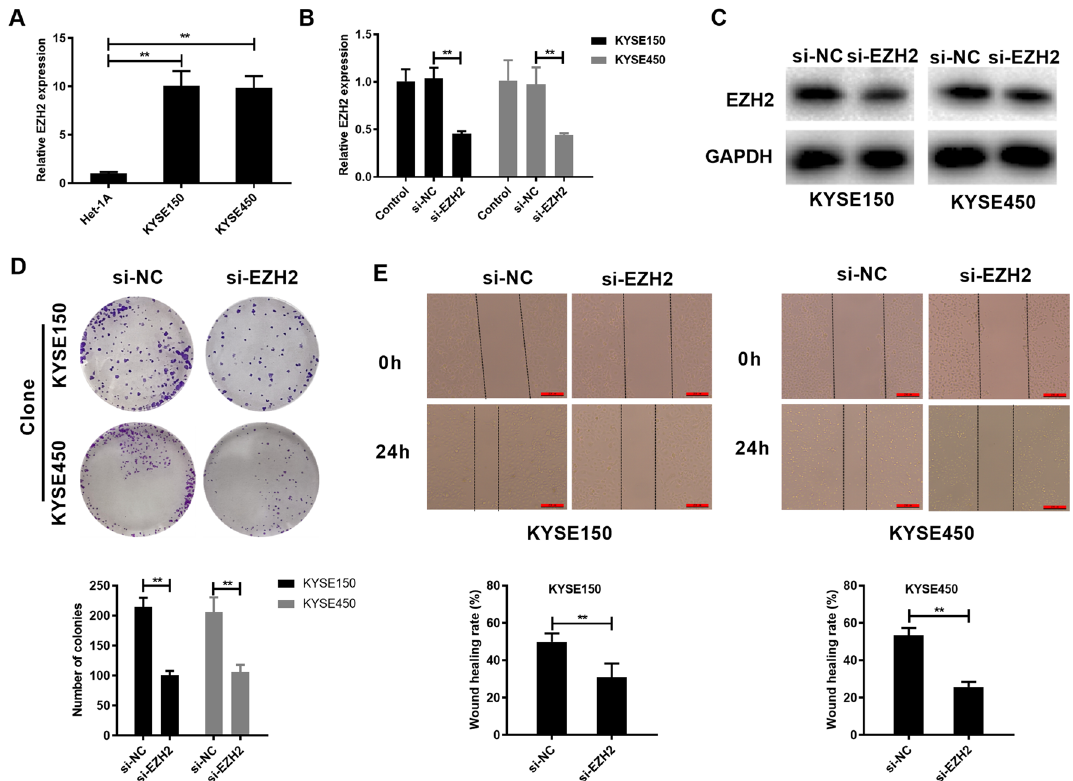
Figure 4. EZH2 promotes colony formation and invasion in EC cells. ( A ) EZH2 levels within EC cells and Het-1A cells. ( B , C ). Transfection of si-EZH2 reduces EZH2 expression in mRNA and protein levels. ( D ) Transfection of si-EZH2 inhibits colony formation of EC cells. ( E ) Transfection of si-EZH2 inhibits migration of EC cells. **P < 0.01 (Two-way Student’s t-test).